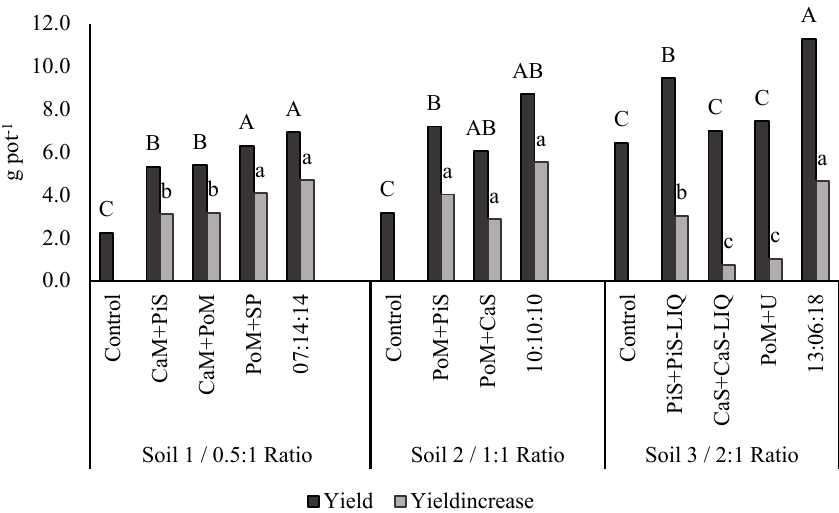
Figure 1. Total yield (DM) and yield increase (Yield increase ). Within each ratio, different letters represent significant differences for p < 0.05 (Tukey test), with capital letters referring to yield and small letters referring to yield increase. PiS: pig slurry; PiS-LIQ: liquid fraction from pig slurry;